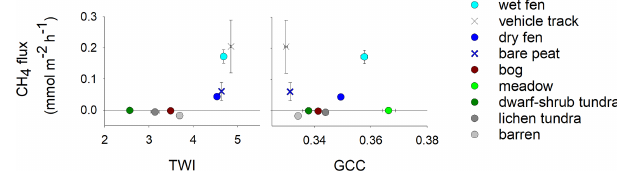
Figure 5. LCT mean ( ± SE) CH 4 fluxes in relation to the cor- responding mean ( ± SE) TWI (excluding the meadow) and mean GCC. Data from years 2012–2019; see Table 3c for the number of measurements.